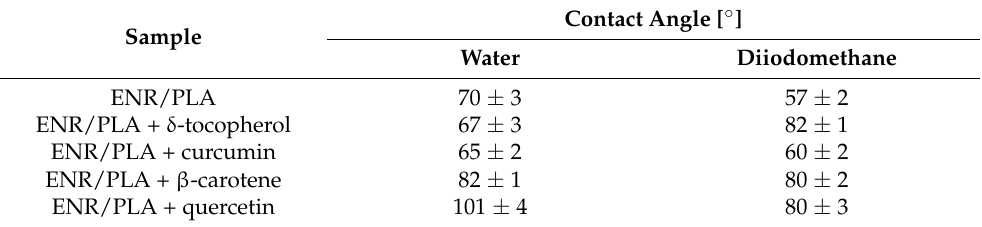
Table 3. Water and diiodomethane contact angles for the unfilled and filled ENR/PLA blend samples.